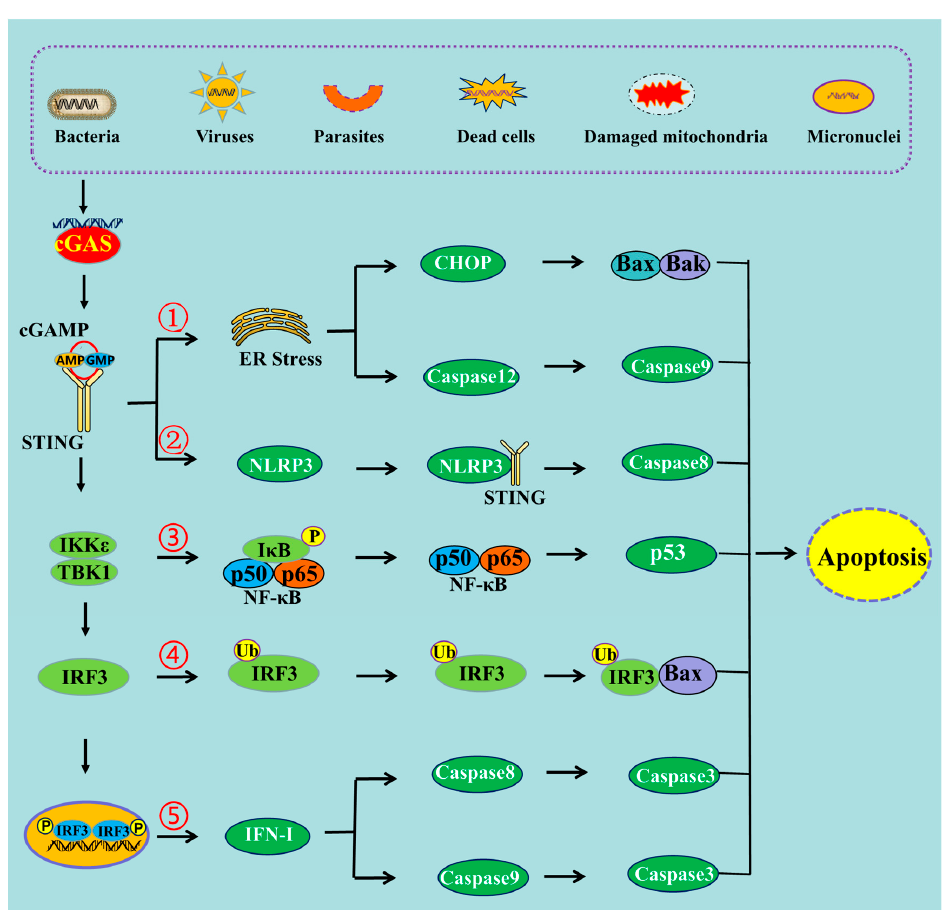
Figure 1. The schematic mechanism of cGAS-STING pathway-mediated apoptosis. ① cGAS-STING